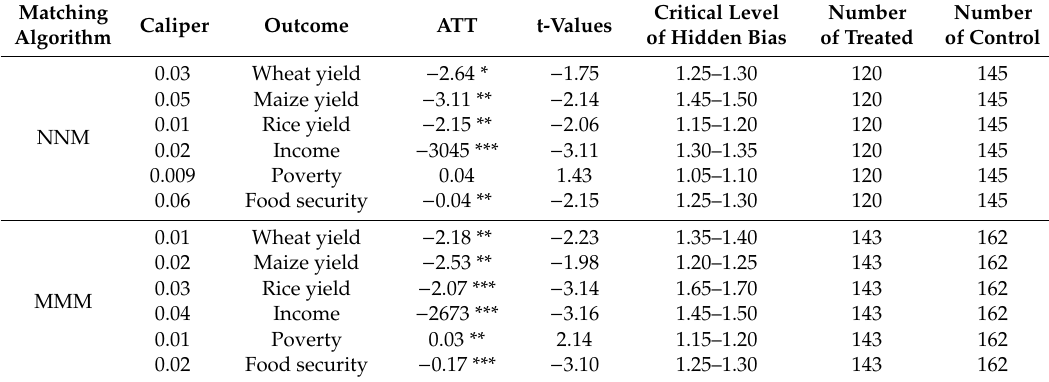
Table 6. Impact of floods on crop yields, household income, food security, and poverty levels. Matching